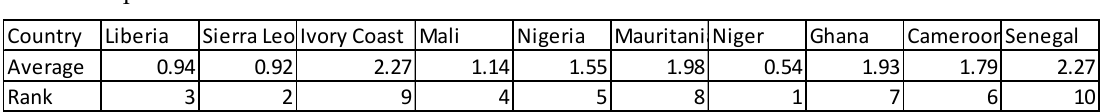
Figure A7. Infrastructure (1990–2017). Source: Authors’ work. Figure A7. infrastructure (1990–2017). Source: Authors’ work.